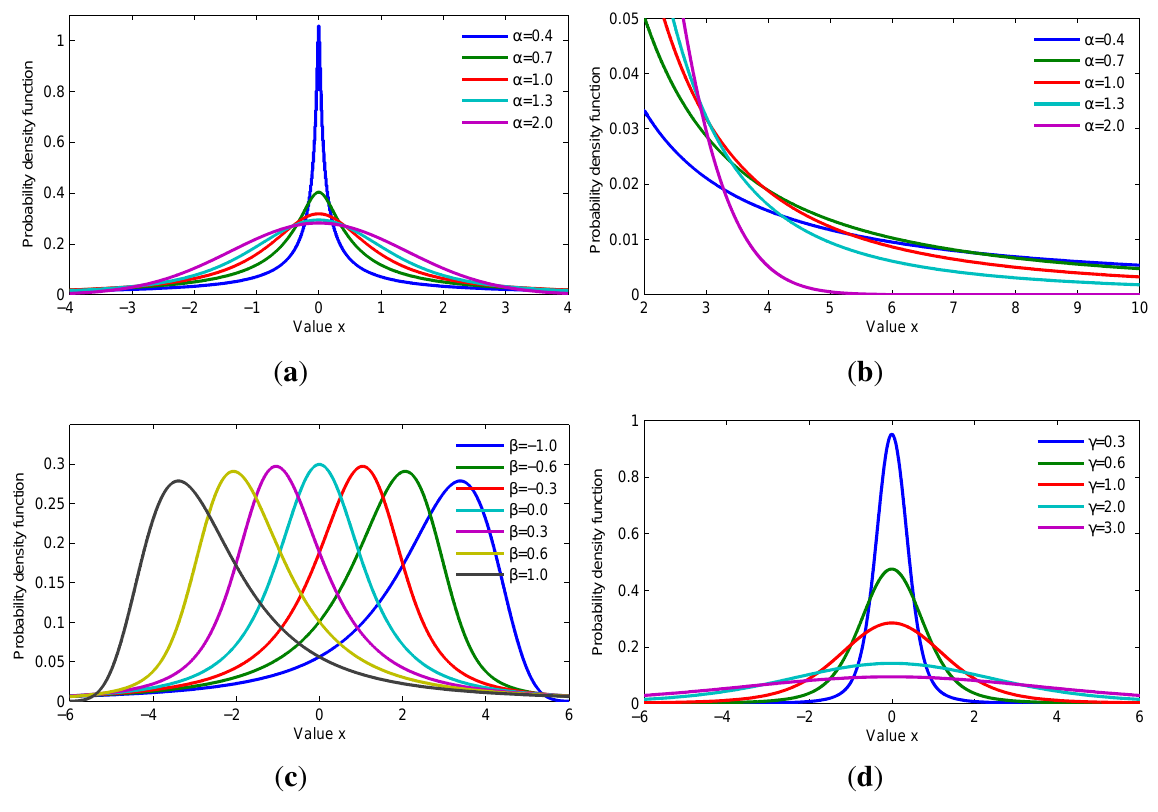
Figure 1. PDF of Alpha-stable distributions ( µ = 0 ). ( a ) Symmetric Alpha-stable case: α = [0.4,0.7 ,1.0,1.3,2.0], β = 0 . 0 , γ = 1 . 0 ; ( b ) Enlargement of the tails in (a); ( c ) Skewness parameter: α = 1 . 2 , β = [0.0,0.2,0.5,0.8,1.0], γ = 1 . 0 ; ( d ) Dispersion parameter: α =